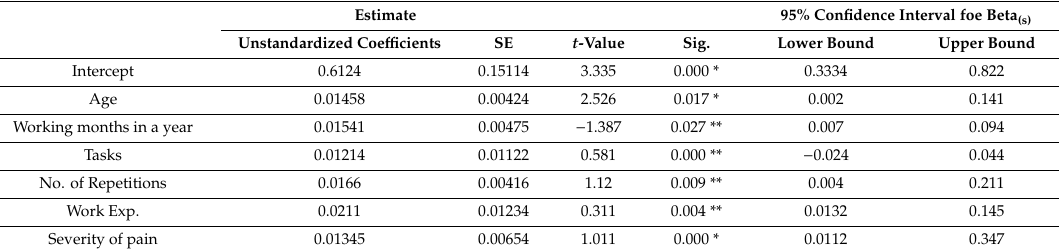
Table 6. Parameter Estimates (Coe ffi cients).